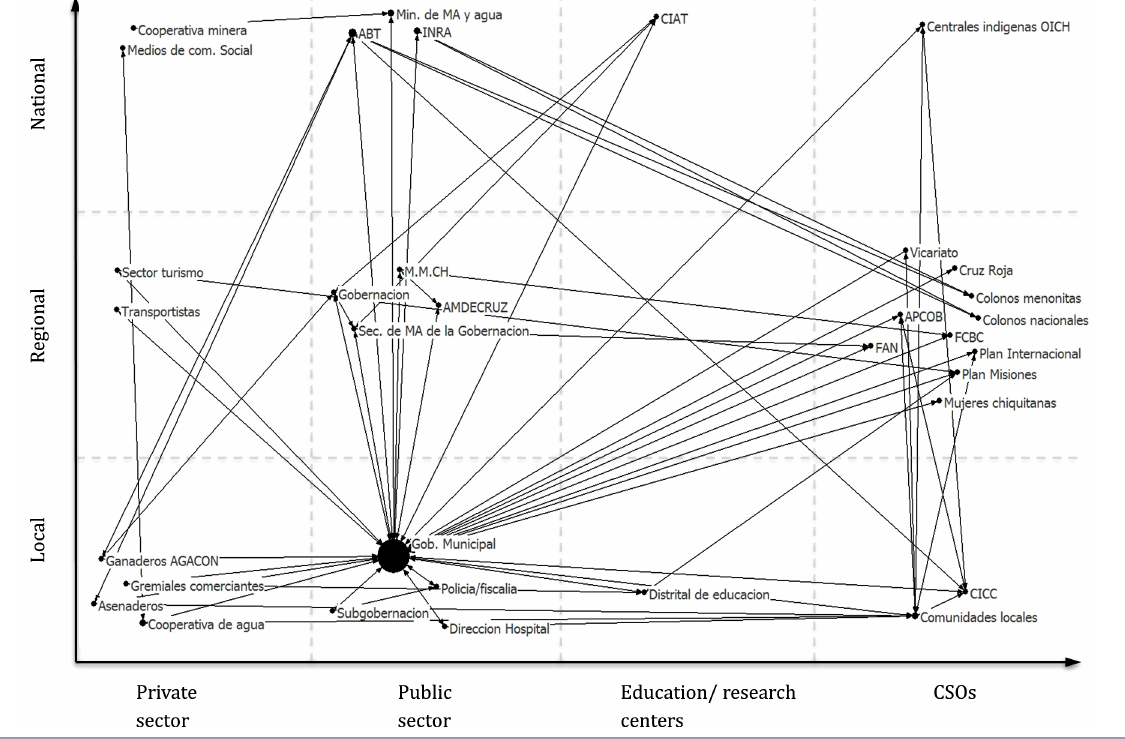
Fig. 2. Water governance network from the perspective of representatives of local public entities in the Chiquitano Model Forest (CMF), Bolivia. The actor nodes in the network represent organizations and social groups perceived as relevant to water resources management. The x-axis categorizes the actor nodes according to their related sector. Civil society organizations (CSOs) include nongovernmental organizations. The y-axis categorizes actor nodes by their scale of action. The local scale relates to the pilot area in the CMF, the regional scale corresponds to the model forest landscape, and the national scale represents Bolivia. Actor node size relates to in-betweenness centrality, which corresponds to the importance of the node as a bridge in the network. See Appendix 2 for water governance networks in the Jujuy Model Forest, Argentina, and the Araucarias del Alto Malleco Model Forest, Chile. See Appendix 3 for a list of the main actors and the role they play in the water governance network according to participants’